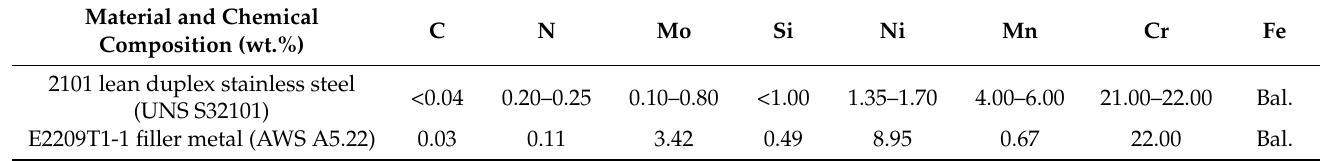
Figure 6. Schematic showing ( a ) the welded 2101 lean duplex stainless steel sample using flux-cored arc welding and ( b ) a cross-section of the weld samples for FIB/TEM at the welded metal zone. Table 3. Nominal chemical compositions of the stainless steel base material and filler metal. Material and Chemical Composition (wt.%)